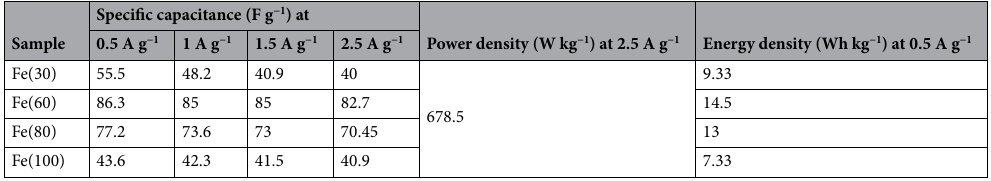
Table 5. Specific capacitances of microwave prepared samples at different